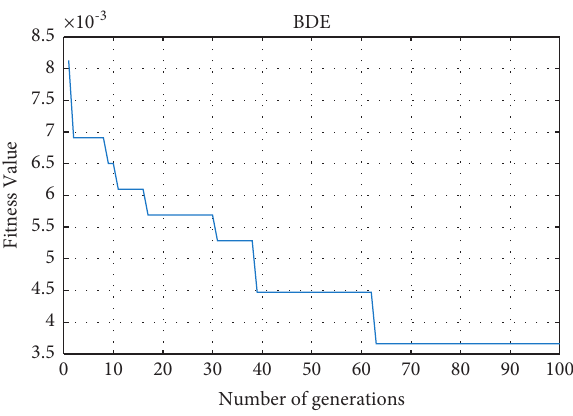
Figure 5: Fitness curve for the binary differential algorithm. Table 1: Confusion matrix average after 100 runs with 3 classes using the (a) optimized features and (b) original features based on the training, test, validation, and total